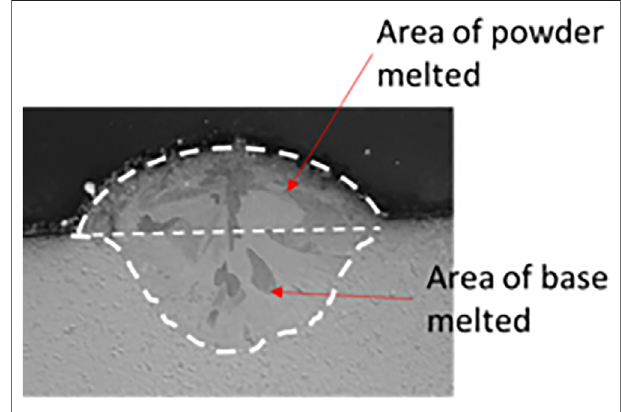
FIGURE 9 | Cross-sectional area of 316L SS bead deposited.